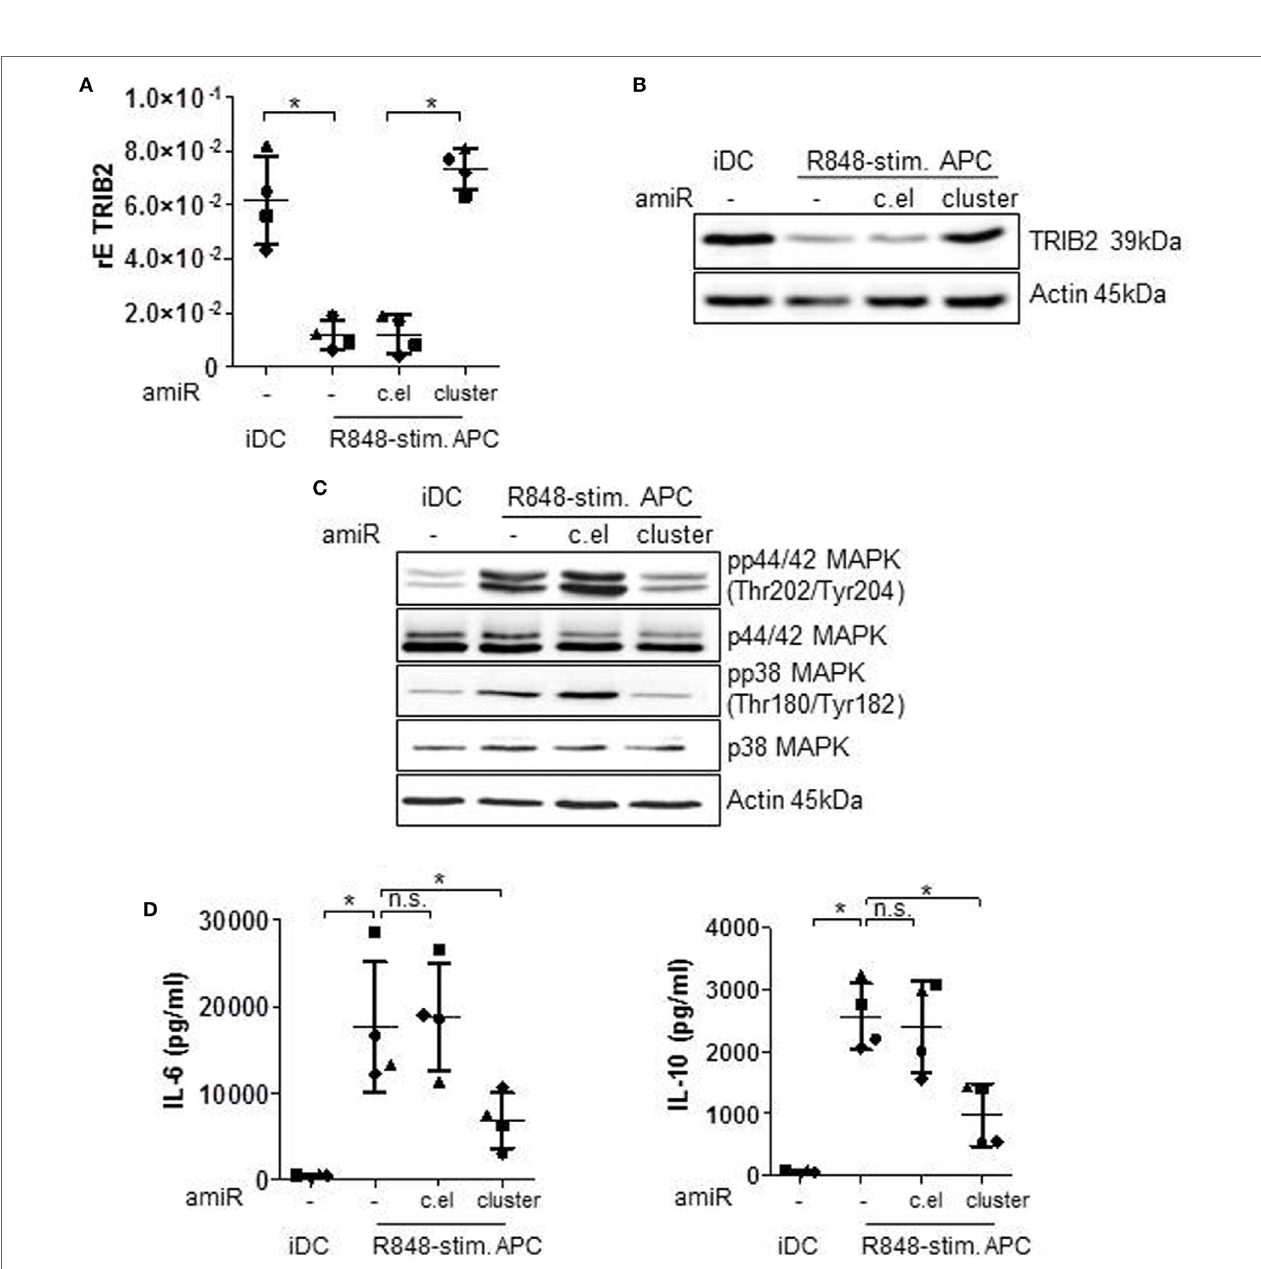
FigUre 3 | Immature DCs (iDCs) and R848-stim.APCs, treated with either a mix of antagomiRs (amiRs) against the cluster of miR-99b, let-7e, and miR-125a or amiRs against C. elegans miRNA (control) or untreated were analyzed as follows. (a) TRIB2 gene expression was analyzed by qRT PCRs. (B,c) For Western blot analysis, equal amounts of protein lysates were blotted and probed with antibodies against TRIB2 (B) , phosphorylated and total p44/42 mitogen-activated protein kinase (MAPK) and p38 MAPK (c) or Actin (loading control). (D) Supernatants were used for Enzyme-Linked Immunosorbent Assay analysis to quantify released IL-6 and IL-10 amounts. (B,c) Shown is one representative Western blot out of three repeats. (a,D) Each symbol represents one donor. Shown is mean and SD. Statistics: * p ≤ 0.05 by Mann–Whitney U test.